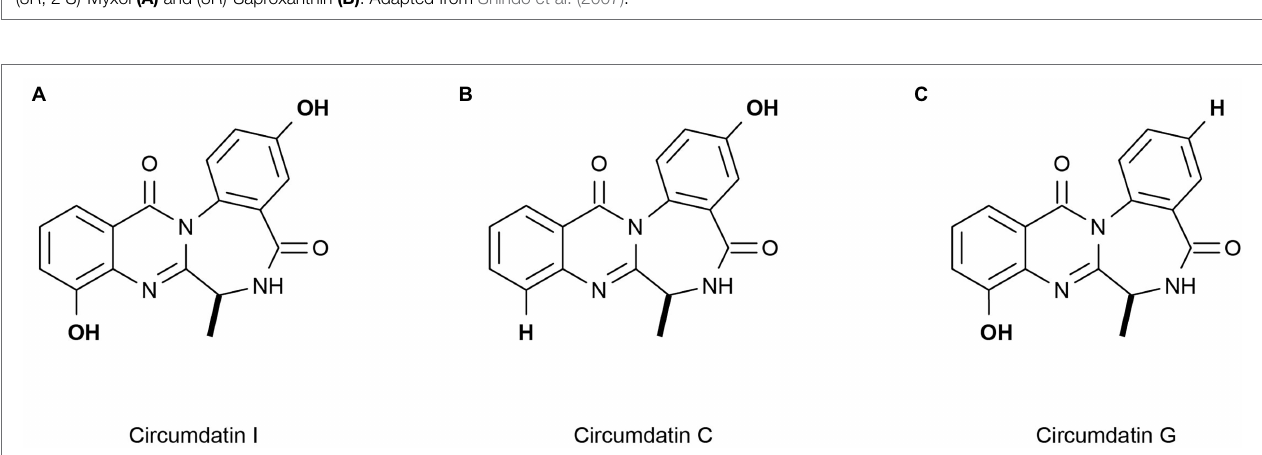
FIGURE 2 | Reprinted with the kind permission of Applied Microbiology and Biotechnology publications. Chemical structures of two rare monocyclic carotenoids (3R, 2’S)-Myxol (A) and (3R)-Saproxanthin (B) . Adapted from Shindo et al. (2007).